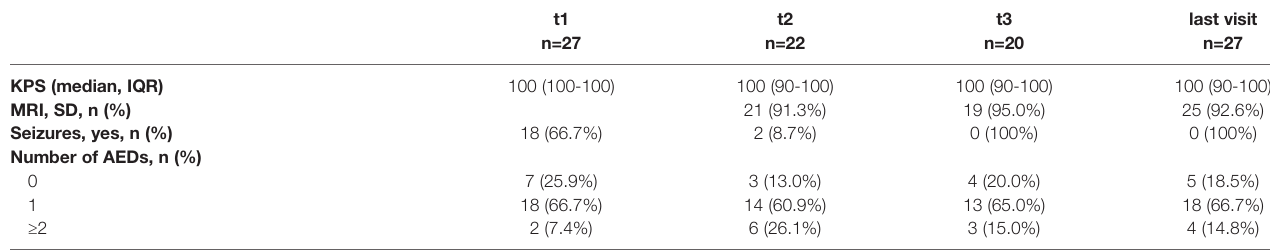
TABLE 3 | Outcome